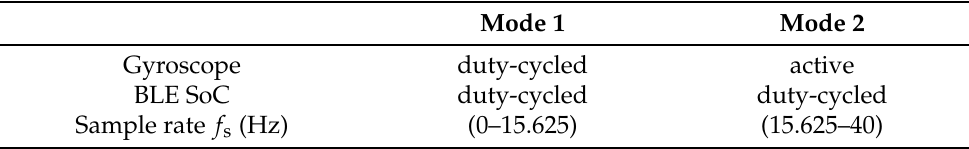
Table 1. Operation modes of the wireless RPM sensor, including supported sample rate ranges and component activity